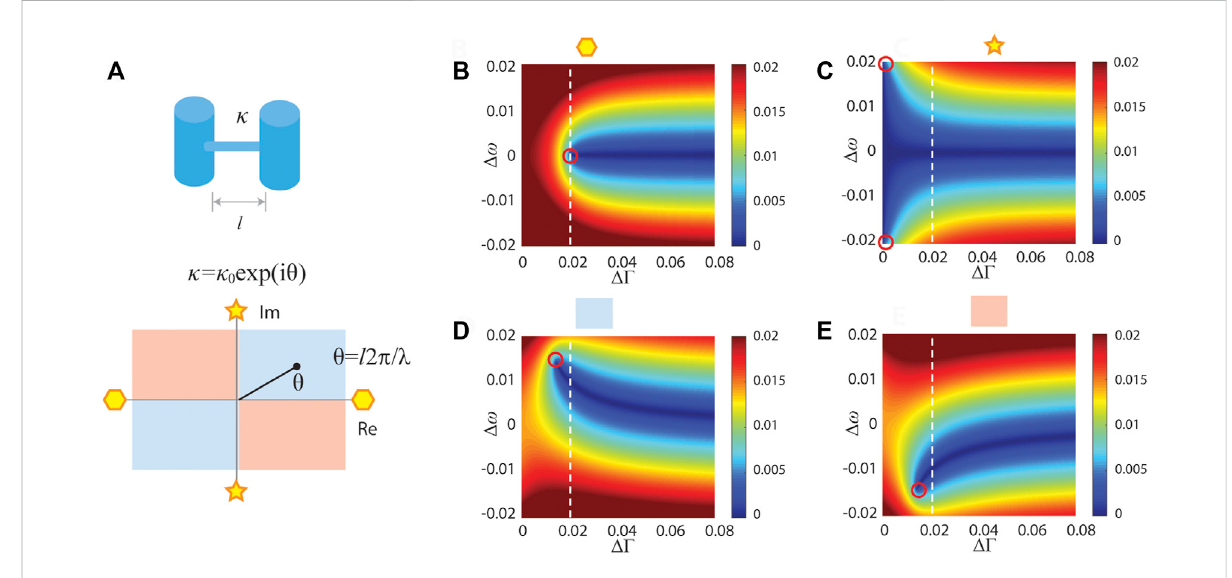
FIGURE 8 Exceptional point in coupled resonators. (A) Coupled cavity resonators having the complex coupling strength ( κ ) and κ = κ 0 exp ( i θ ). (B) Square- roottermfor θ = π /4+ n π .Theredcircleindicatesthecondition( ΔΓ and Δ ω )forthezerosquare-rootterm. (C) Pureimaginarycoupling( θ = π /2+ n π ). (D) π /4 + n π (E) 3 π /4 + n π